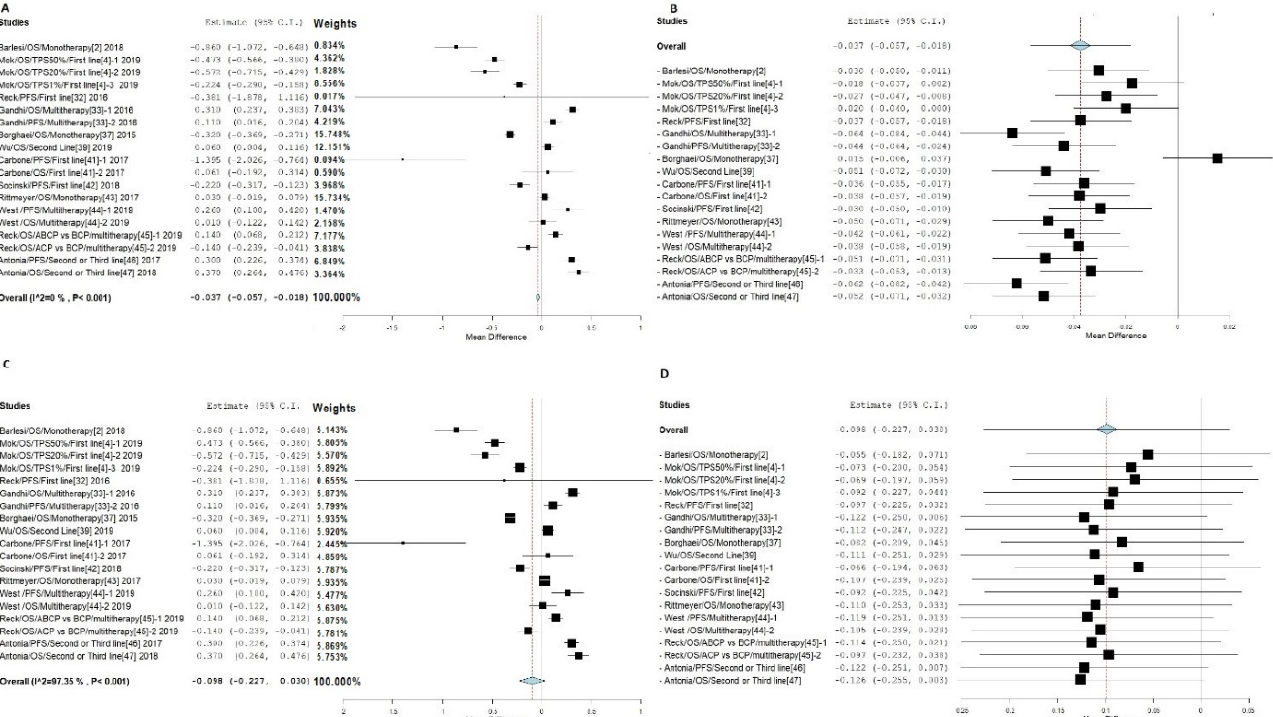
Figure 2. Meta-analysis of response to treatment compared between smoker and non-smoker NSCLC patients. ( A ) Shows results of the FE model with all sets of data. ( B ) Shows results of FE with the leave-one-out model. ( C ) Shows results of the RE model with all data. ( D ) Shows results of the RE model with the leave-one-out model.